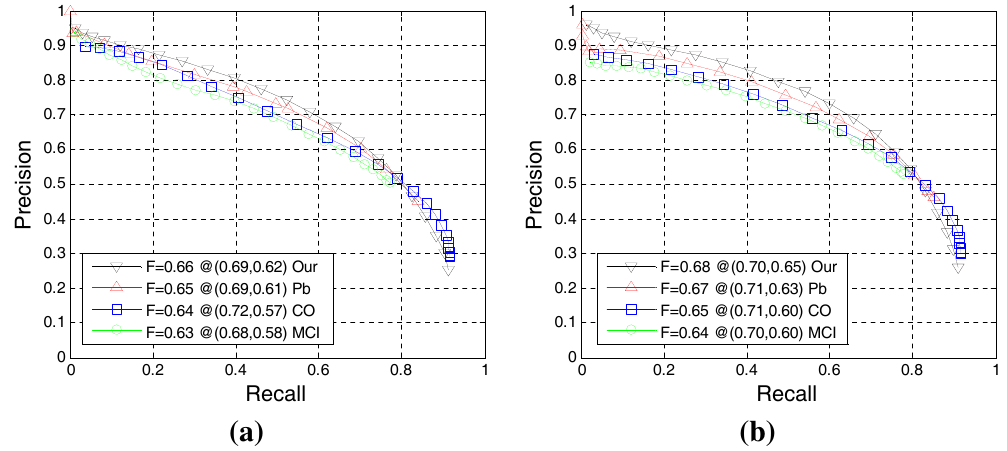
Figure 6. ( a ) The overall performance of the P-R curve on BSDS300 [26]; ( b ) the overall performance of the P-R curve on BSDS500